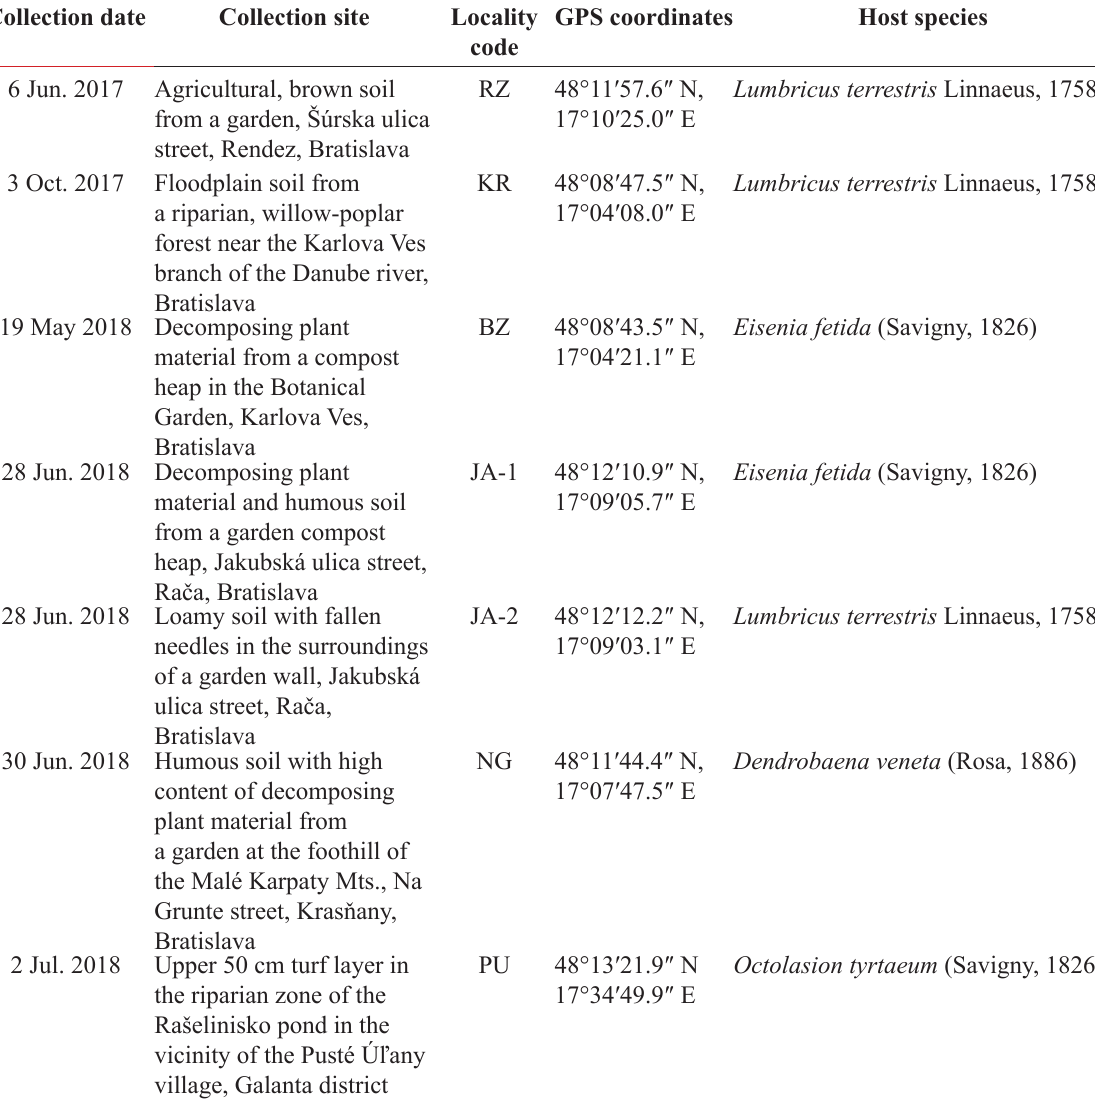
Table 1. Characterization of collection sites of earthworm species examined for the presence of astome ciliates. For localization of localities, see Fig.